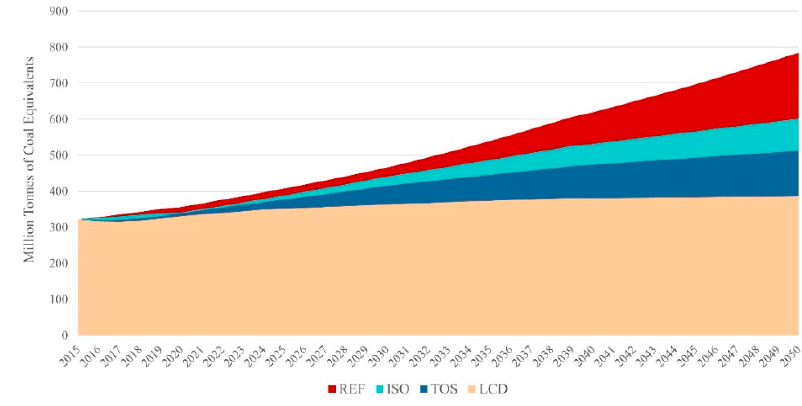
Figure 3. The energy consumption in each scenario in 2015–2050.